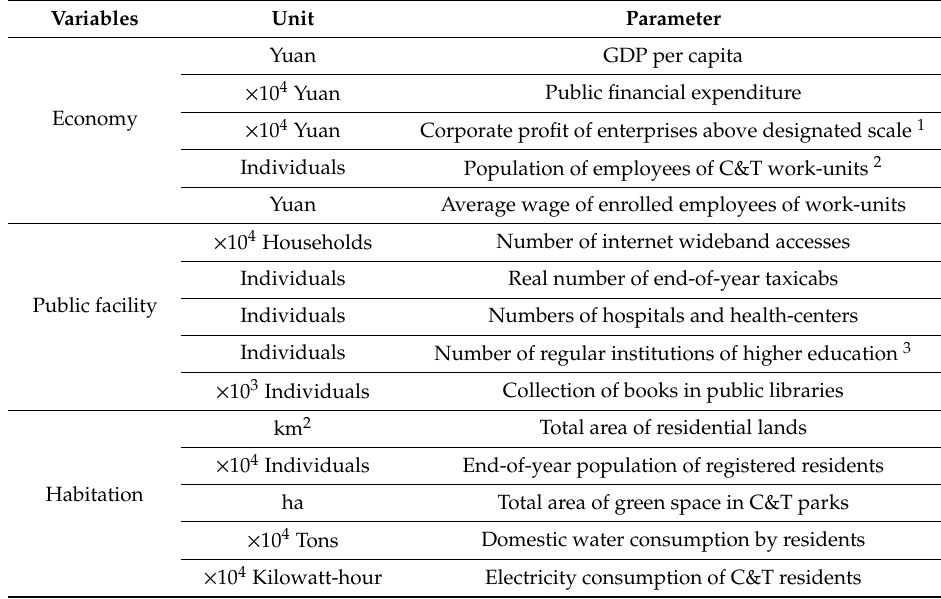
Table 1. Specific parameters used in city variables about economy, public facility, habitation, and